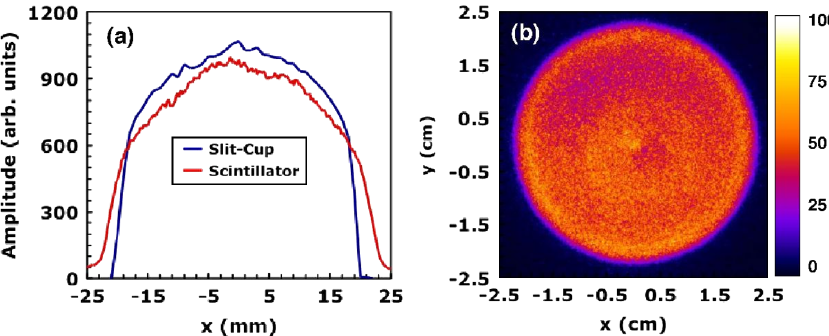
MATCHING AND TRANSPORTING AN INTENSE . .